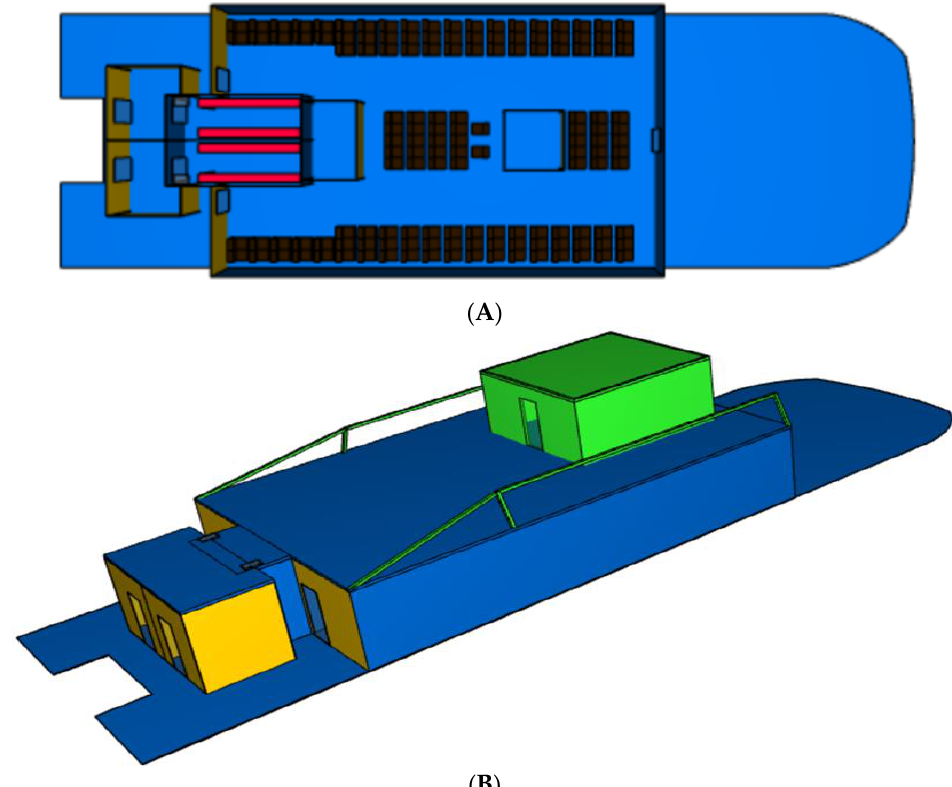
Figure 6. Three-dimensional geometry model of the ferry in PyroSim (( A ) battery room deck; ( B ) with superstructure).